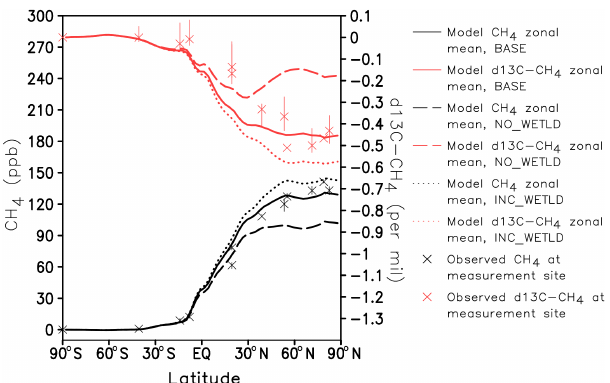
Figure 7. The difference between surface annual mean CH 4 and δ 13 C-CH 4 and South Pole annual mean values. Model results are compared to NOAA-ESRL and CU-INSTAAR observations. Black represents CH 4 mixing ratios, and red represents δ 13 C-CH 4 frac- tionations. Where there are sufficient data available in the 2005– 2009 period, the range in annual mean station South Pole observed differences is represented by a vertical bar. Solid lines represent model results from the BASE scenario. Dashed lines represent model results from the NO_WET scenario (where wetland emis- sions >50 ◦ N have been removed relative to BASE). Dotted lines represent model results from the INC_WETLD scenario (where wetland emissions >50 ◦ N have been increased by 50% relative to